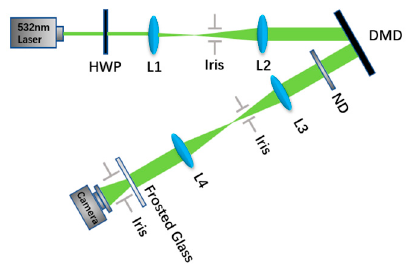
Figure 13. Experimental new data acquisition optical path diagram.